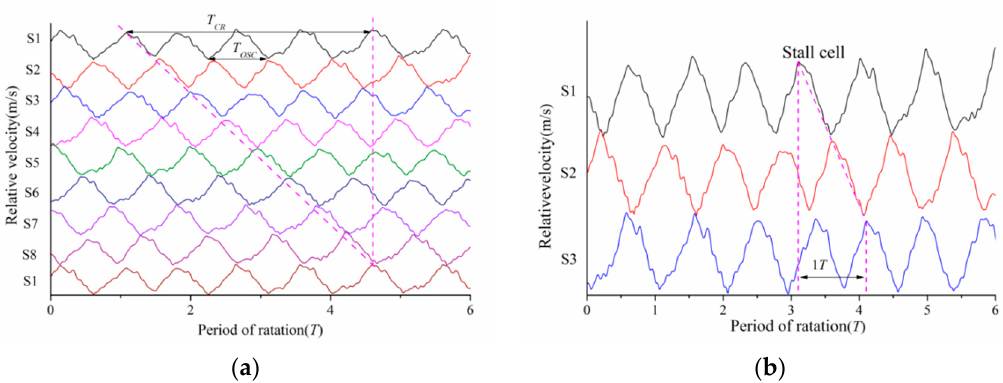
Figure 8. Relative velocity curve of the monitoring point when the flowrate is 1.0 kg/s: ( a ) The curve of relative velocity at 8 points; ( b ) the curve of relative velocity at 3 adjacent points.